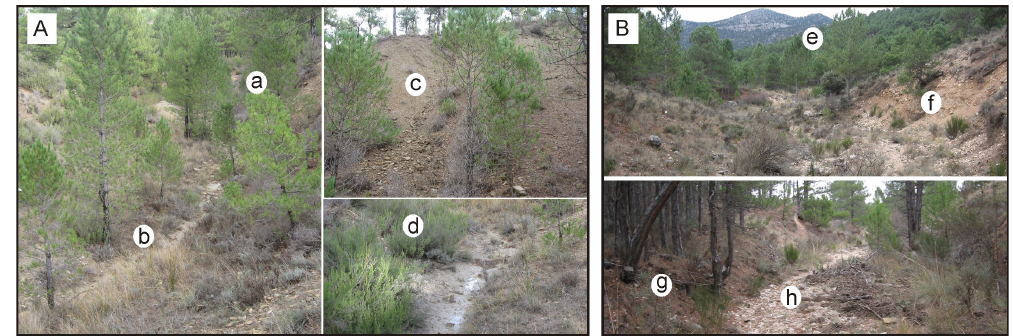
Fig. 3. A (C51): (a) low density forest; (b) vegetation encroachment and channel incision; (c) talus slope with input of sediments by mass waste processes and (d) vegetation in the inner plain and at the slope base retaining eroded material. B (C24): (e) high density forest; (f) talus slopes with a concave base; (g) well-connected lateral slopes with interrill erosion and litter input to the channel and (h) channel